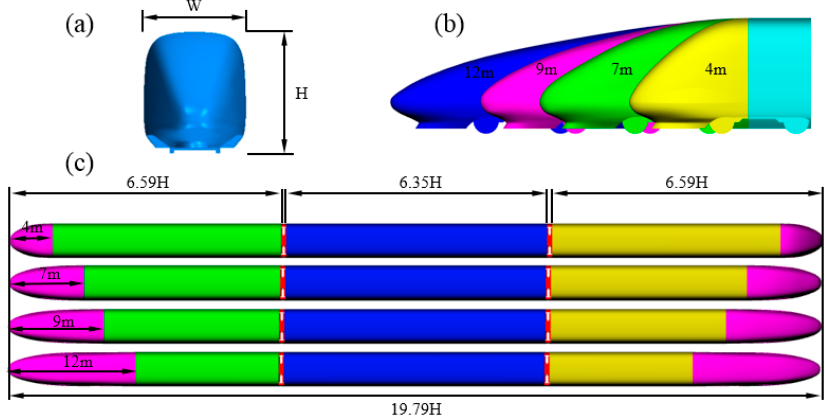
Figure 1. Train model. ( a ) Height and width, ( b ) di ff erent nose lengths, ( c ) top view.